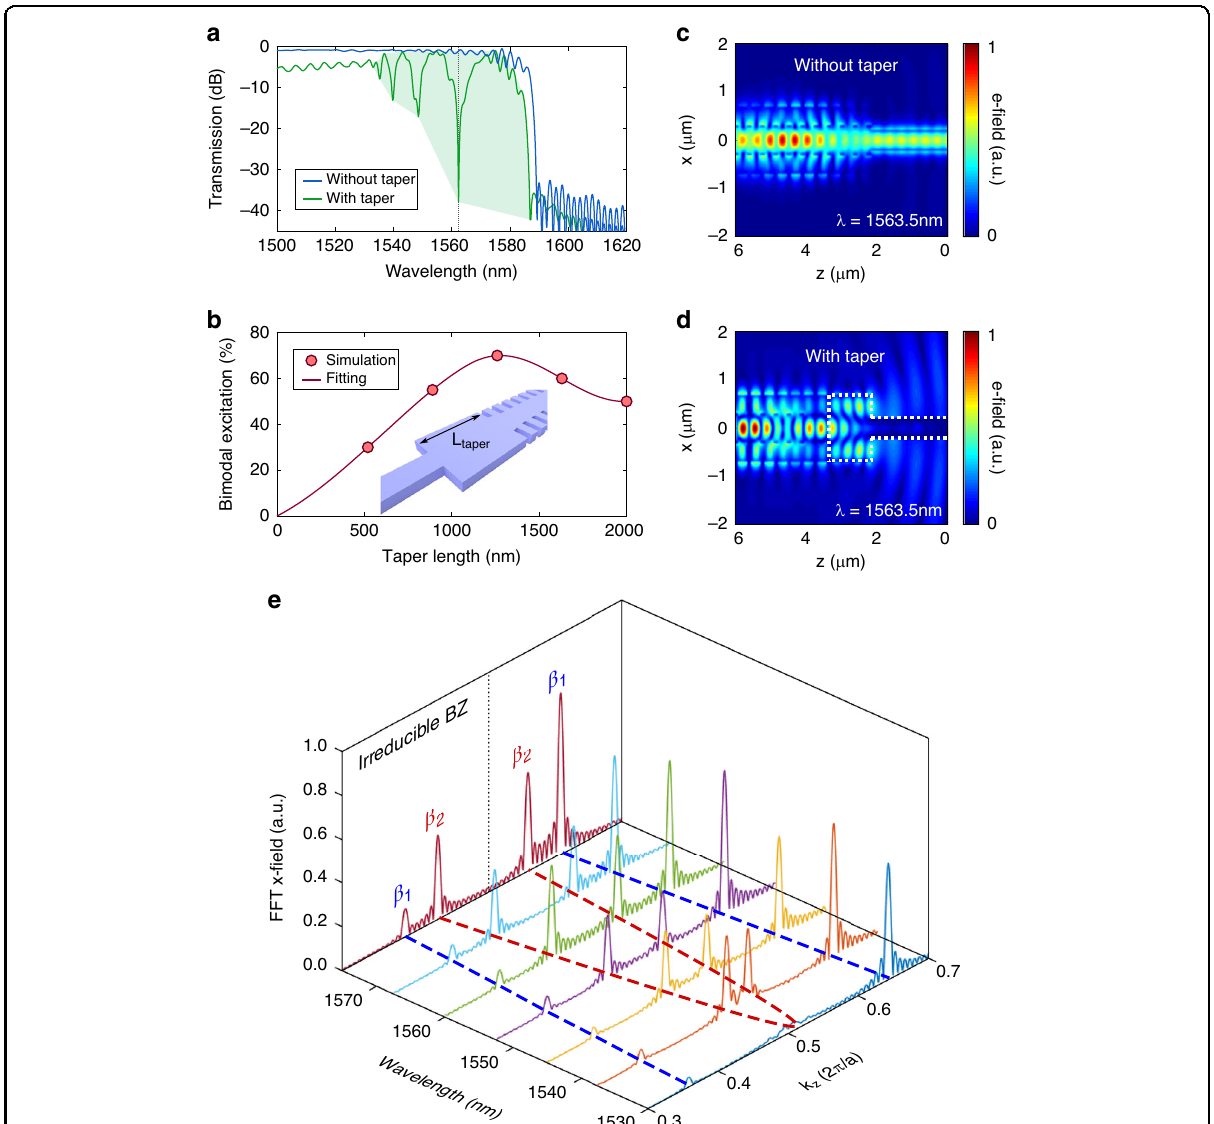
Fig. 3 Simulation of the bimodal behaviour. a Transmission spectra for a bimodal PhC interferometer with and without a rectangular taper of 1200 nm with the previously detailed design parameters and for N = 150 cell units repeated along the z -axis. The green shaded area represents the region of interest of the interferometer, corresponding to the bimodal region near the PBG. b Modal excitation obtained from the amplitude difference between constructive and destructive interference in the spectrum for different taper lengths. The inset details the value under consideration in a 3D sketch. c , d Electric fi eld absolute value for the xz plane and y = 0 at the output interface between the bimodal periodic part and the single-mode waveguide with and without a rectangular taper between interfaces. e FFT amplitude of the electric fi eld x -component along the propagation direction z for different wavelengths in the bimodal region. The dashed blue and red lines in the wavelength- k z plane represent the dispersion relations of the fundamental and higher-order modes, respectively. The irreducible and second Brillouin zones are